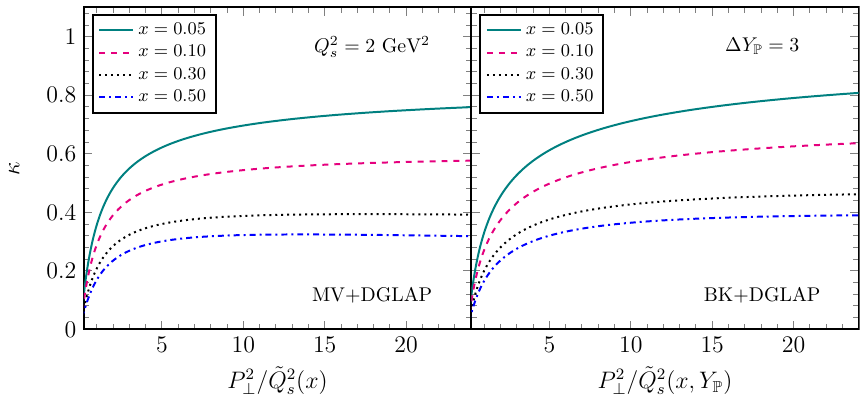
(cid:0) (cid:1) x, Y , P 2 / ˜ Q 2 ( x, Y ) , defined in eq. (5.23) s ⊥ P P . Left panel: the source term in the DGLAP P